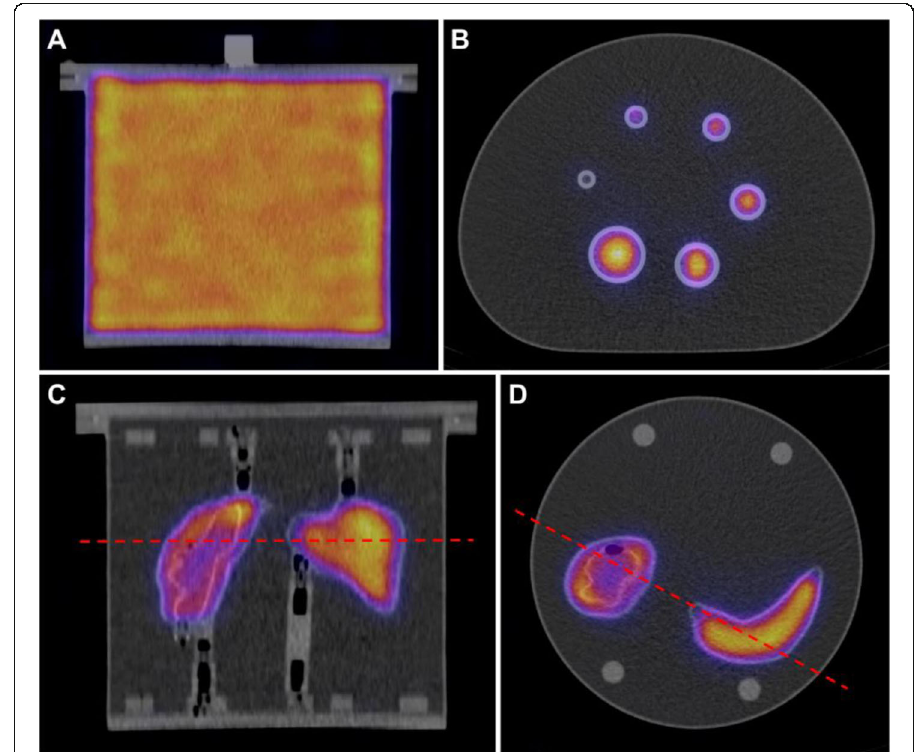
Fig. 3 Example SPECT/CT reconstructions for a Siemens Intevo Bold system. A Coronal view of Jaczszak phantom. B Axial view of NEMA phantom. C Coronal view of Two-Organ (kidney and spleen) phantom. D Axial view of Two-Organ phantom. The red lines indicate the position of the axial cut for the